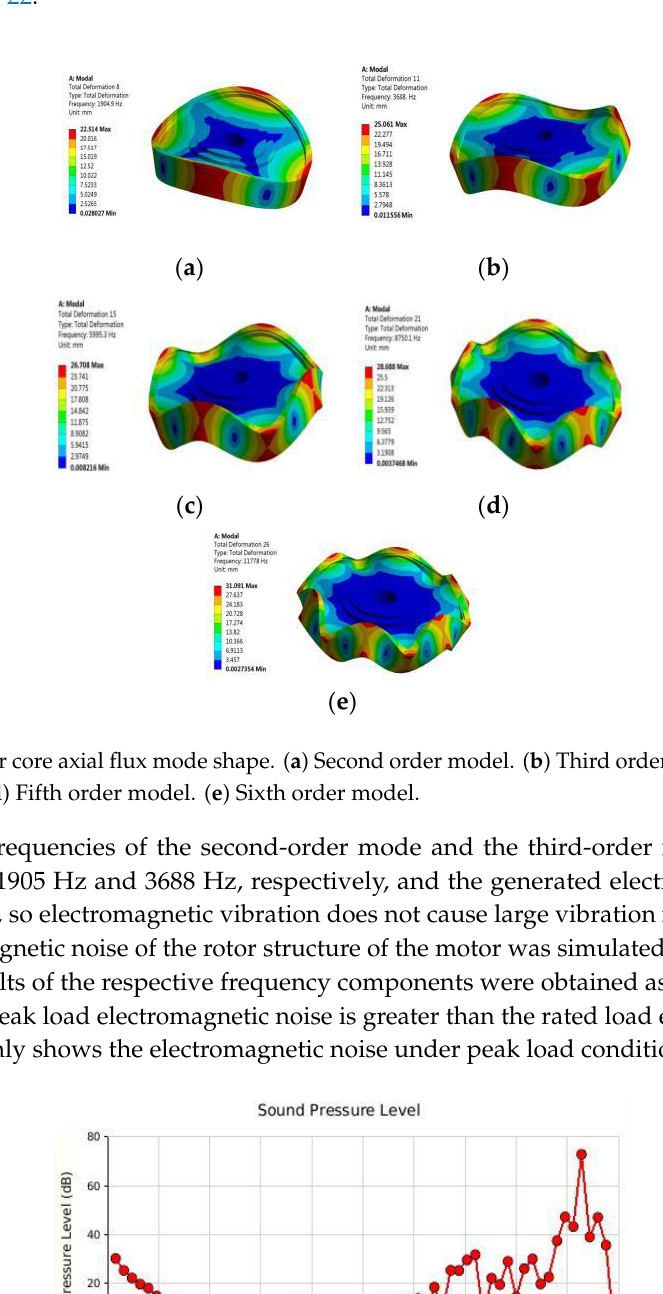
Figure 24. Value-loaded electromagnetic noise at a speed of 3000 rpm. Calculated by Formula (11), the peak load electromagnetic noise of 1600 r/min is 72 dB; the peak load electromagnetic noise of the motor speed of 3000 r/min is 71 dB. The electromagnetic noise generated by the stator structure is the main source of AFPMSMs. When the electromagnetic performance of the vehicle motor was evaluated, the magnetic field saturation of the constant torque working point was the largest, and the magnetic field distortion of the working point of the constant power maximum speed was the largest, which is the typical working condition of the traction motor for the vehicle. Therefore, the maximum speed operating point of the constant torque zone and the maximum speed operating point of the constant power zone are often selected as the key working points of the electromagnetic performance. In summary, the rated load and peak load electromagnetic noise of the stator structure at the constant torque operating point are 80 dB and 88 dB, respectively, and the rated load and peak load electromagnetic noise at the constant power maximum speed operating point are 81 dB and 86 dB, respectively. The peak load electromagnetic noise of the rotor structure at the constant torque operating point is 72 dB, and the peak load electromagnetic noise at the constant power maximum speed operating point